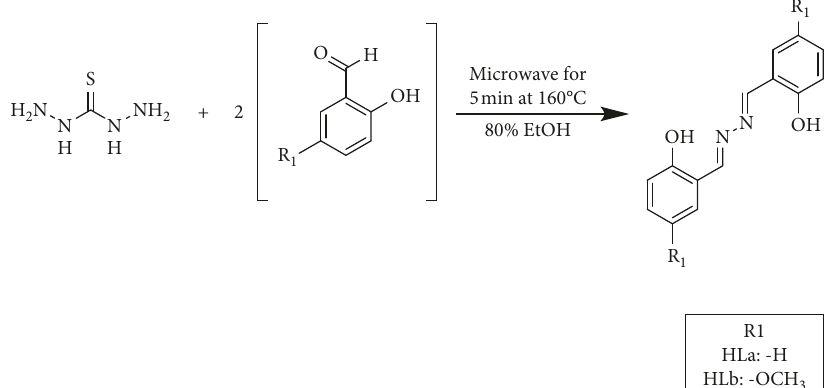
Figure 1: General pathway of synthesizing HLa and HLb